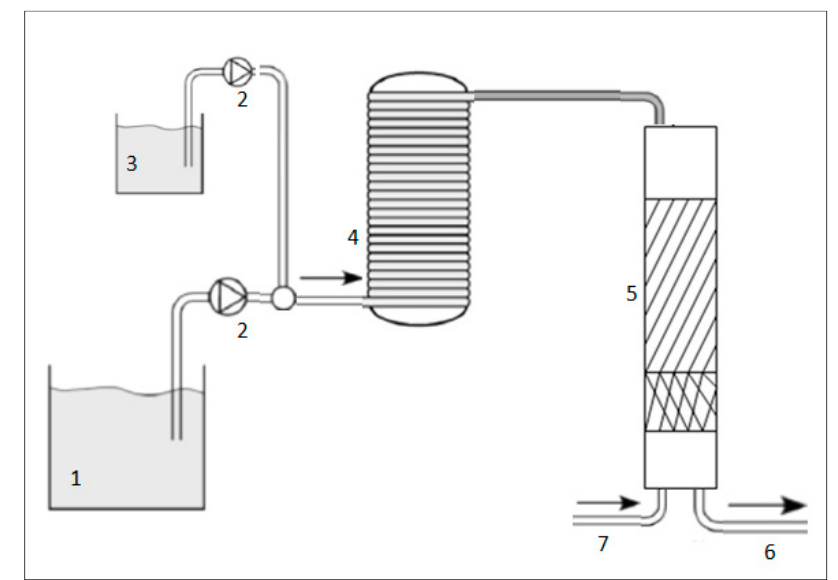
Figure 1. Schematic presentation of chromium (VI) removal process. (1: Influent: Chromium (VI) spiked drinking water, 2: peristaltic pump, 3: Reductant addition unit, 4: Pipe reactor system, 5: Bi-layered sand filter, 6: Effluent, 7: Backwashing inlet. Column height: 1m, Sand bed height: 50 cm, Inner diameter: 68 mm).